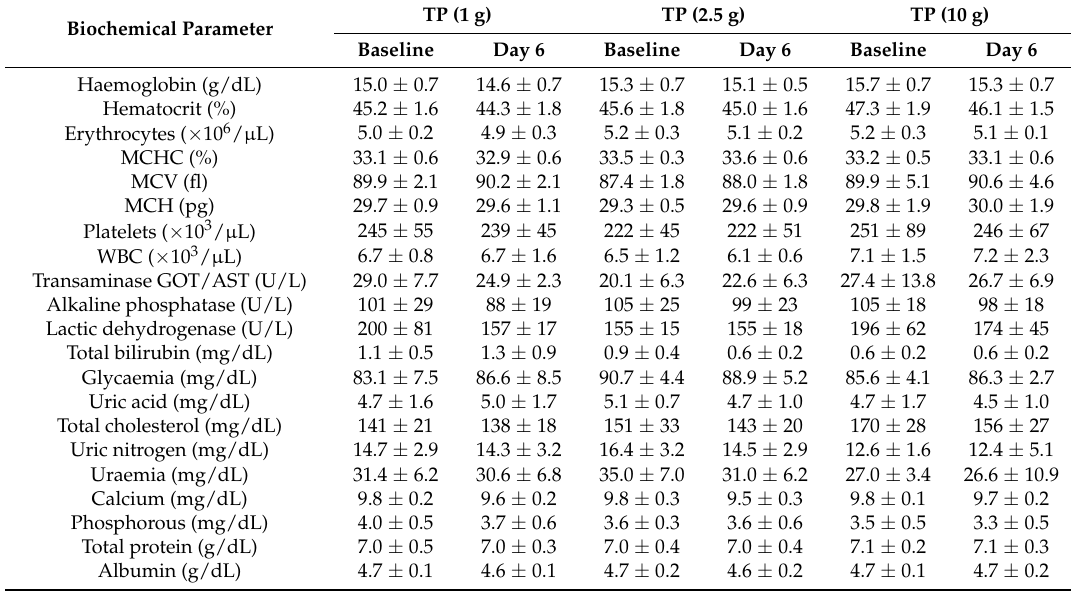
Table 3. Clinical biochemistry of participants before and after ingestion of tomato pomace extract for five days across 3 different doses (Phase 1 study: tolerance).